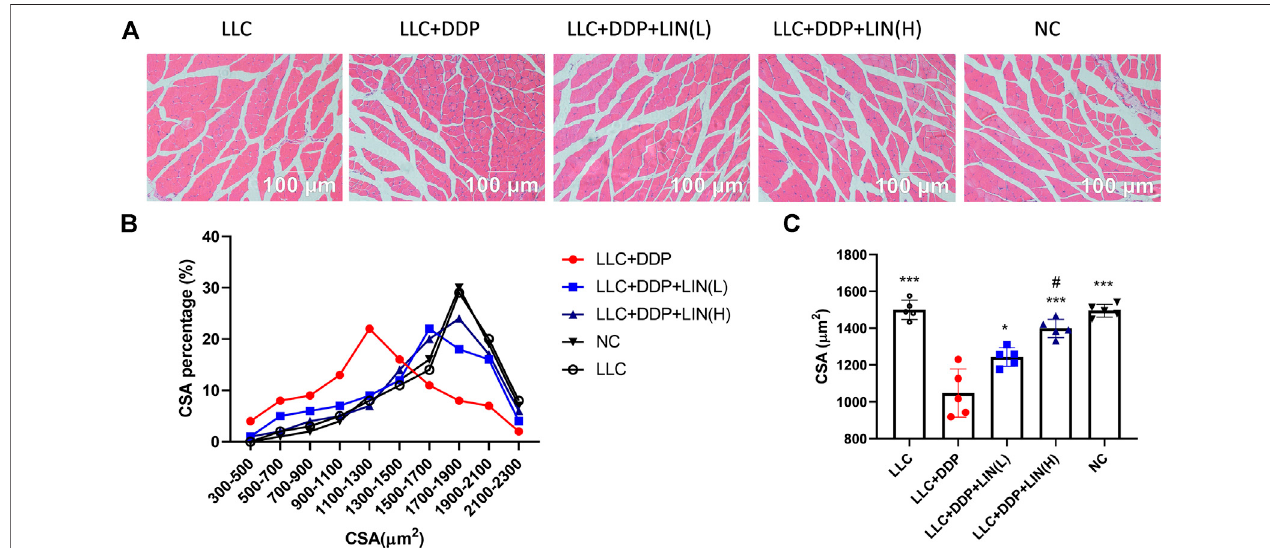
FIGURE 2 | LIN increases the CSA of muscle fi bers in mice after DDP treatment. The sections from the GA muscle were stained with H&E and observed under a microscope (A) a group of representative pictures are shown. (B) Muscle fi ber size distribution. (C) The CSA was measured using Cellsens softwareand the mean CSA of GA muscle from each mouse has been represented (n (cid:2) 5). *** p < 0.001 vs. Group LLC + DDP, # p < 0.05 vs. Group LLC + DDP +